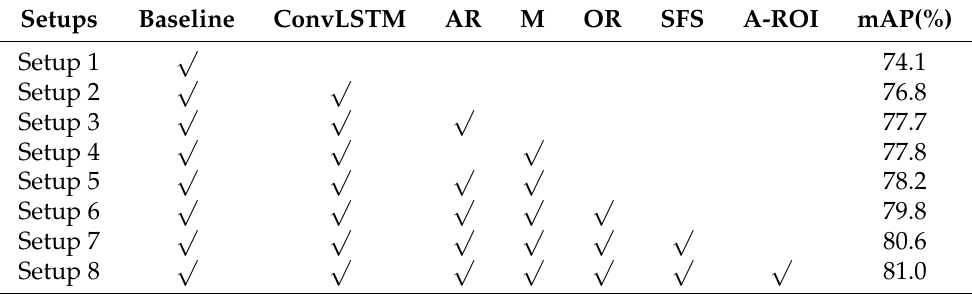
Table 1. Performance comparison of different setups using ImageNet VID validation set. (Baseline: Faster R-CNN still-image baseline detector. AR: Aspect ratio change detection module for ConvLSTM. M: Motion event detection module for ConvLSTM. OR: Object relation module. SFS: Supporting frame selection module. A-ROI: Adaptive ROI